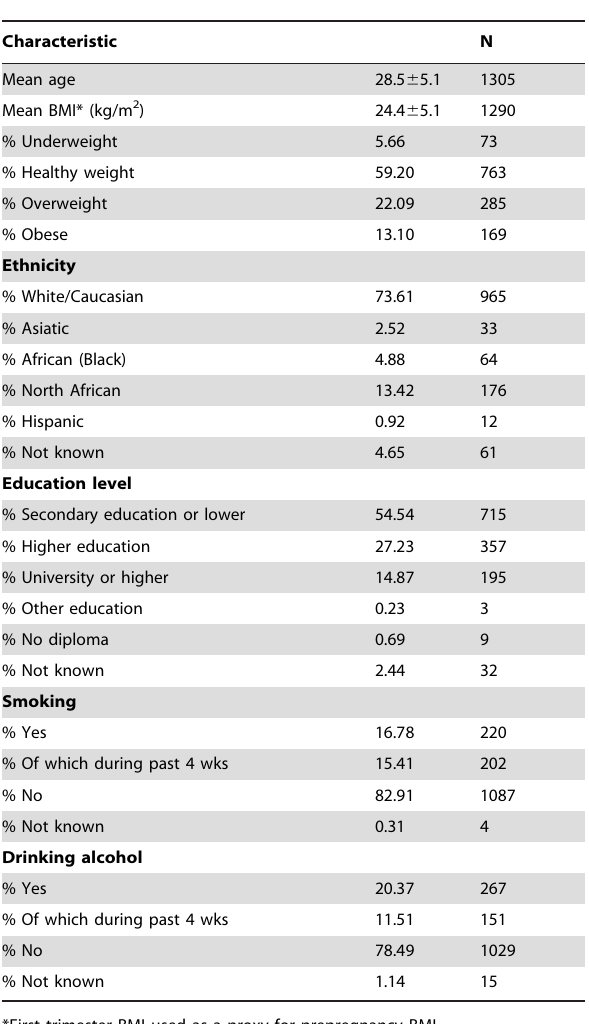
*First trimester BMI used as a proxy for prepregnancy BMI.